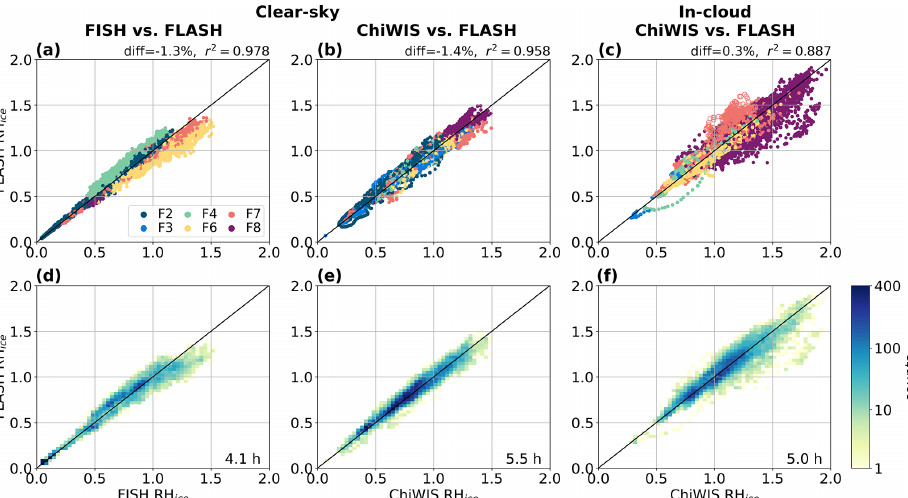
Figure 8. RH ice correlations between the three in situ hygrometers: (a) clear-sky FISH vs. clear-sky FLASH, (b) clear-sky ChiWIS vs. clear- sky FLASH, and (c) in-cloud ChiWIS vs. in-cloud FLASH, with the 1 : 1 line in black. Points in panels (a) – (c) are colored by flight number and plotted in random order. The total hours of paired observations are shown in the bottom right corner, and the percentage difference and r 2 coefficients are shown above each panel. Panels (d) – (f) show the same information as (a) – (c) but as the frequency of observations over all the flights in each 0.03 by 0.03 bin. The largest differences between paired observations occur on F8 in fresh convective outflows with very high in-cloud RH ice . Flight-to-flight differences between FISH and FLASH H 2 O are also noticeable in RH ice . The open circles in panel (c) on F7 mark the time period of disagreement between ChiWIS and FLASH as the airplane was ascending out of a deep